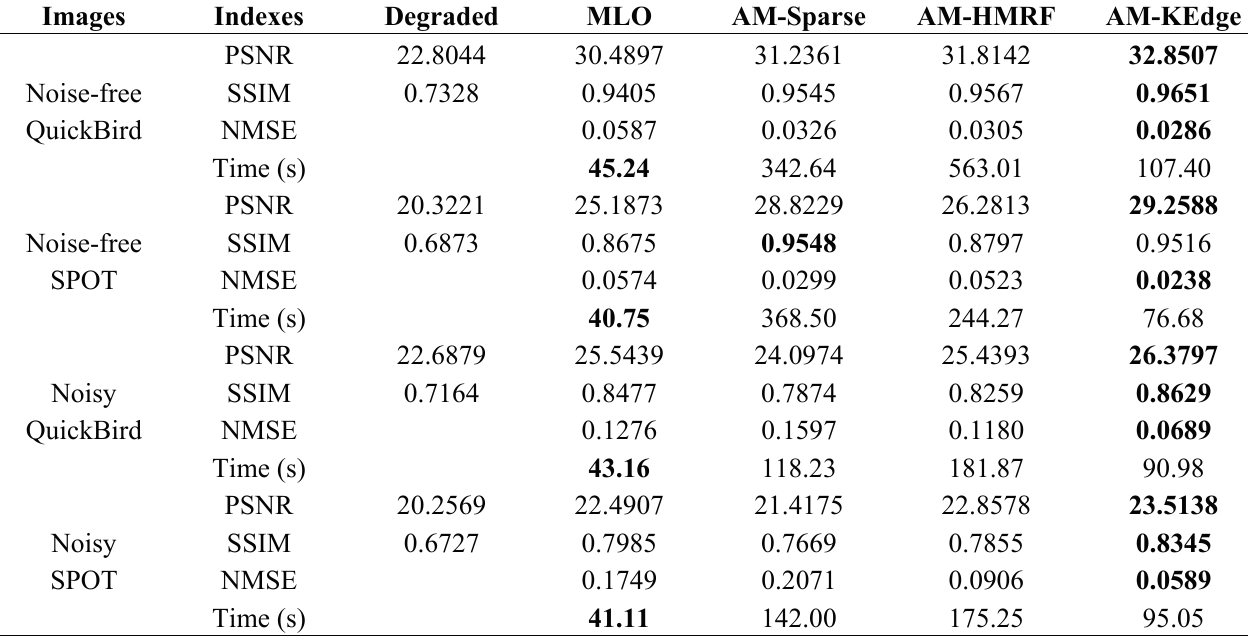
Table 1. Peak signal-to-noise ratio (PSNR), structural similarity (SSIM), and normalized mean square error (NMSE) results, and the computation times in the simulated